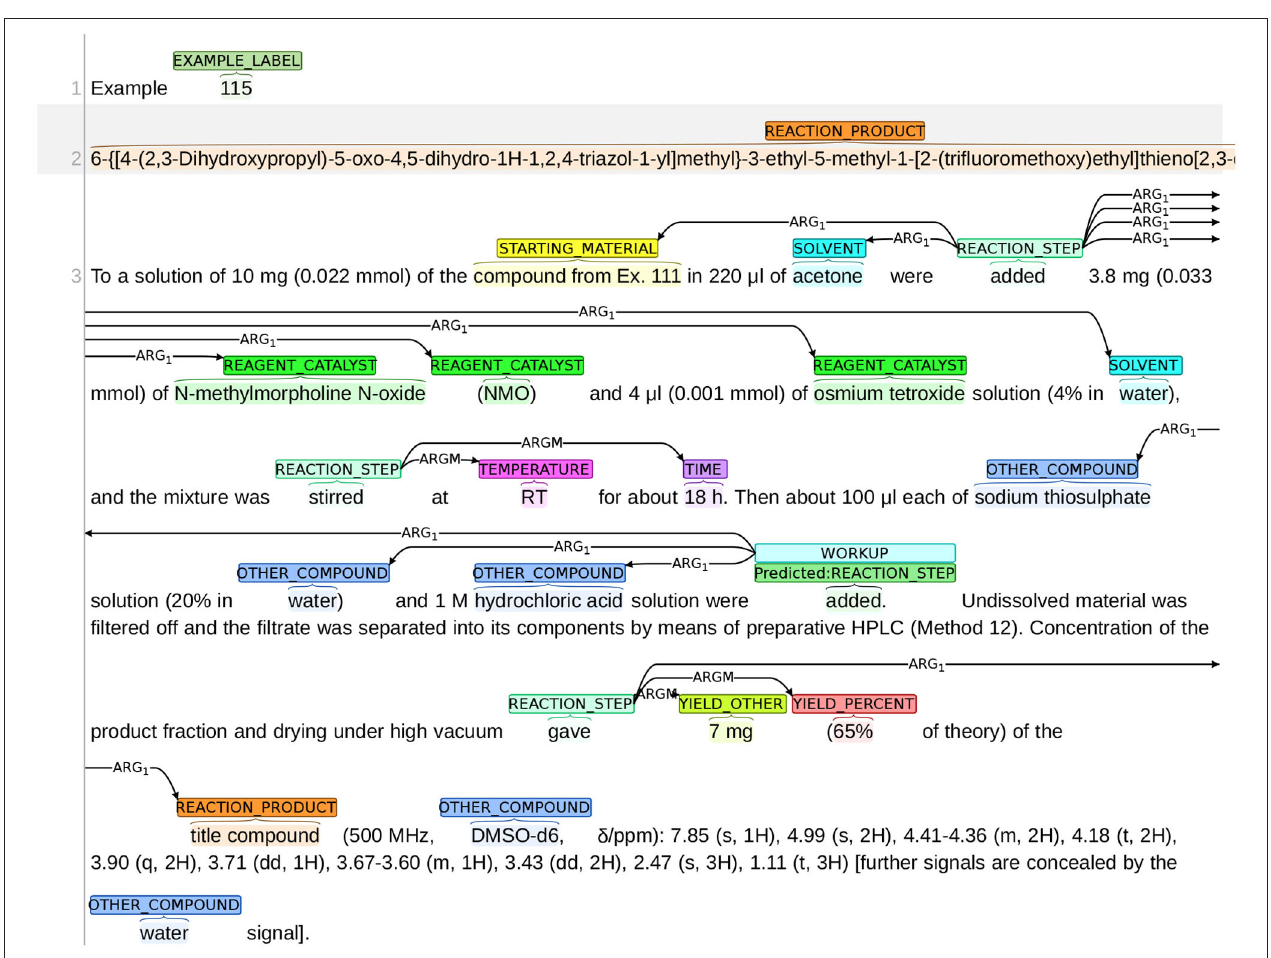
FIGURE 13 | An example of misclassifying WORKUP as